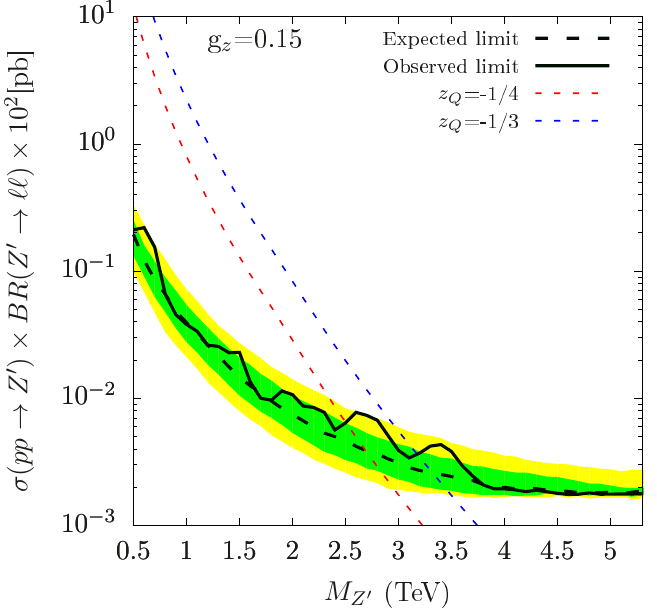
! 1 = 4 and 1 = 3 choices. (cid:0) (cid:0)